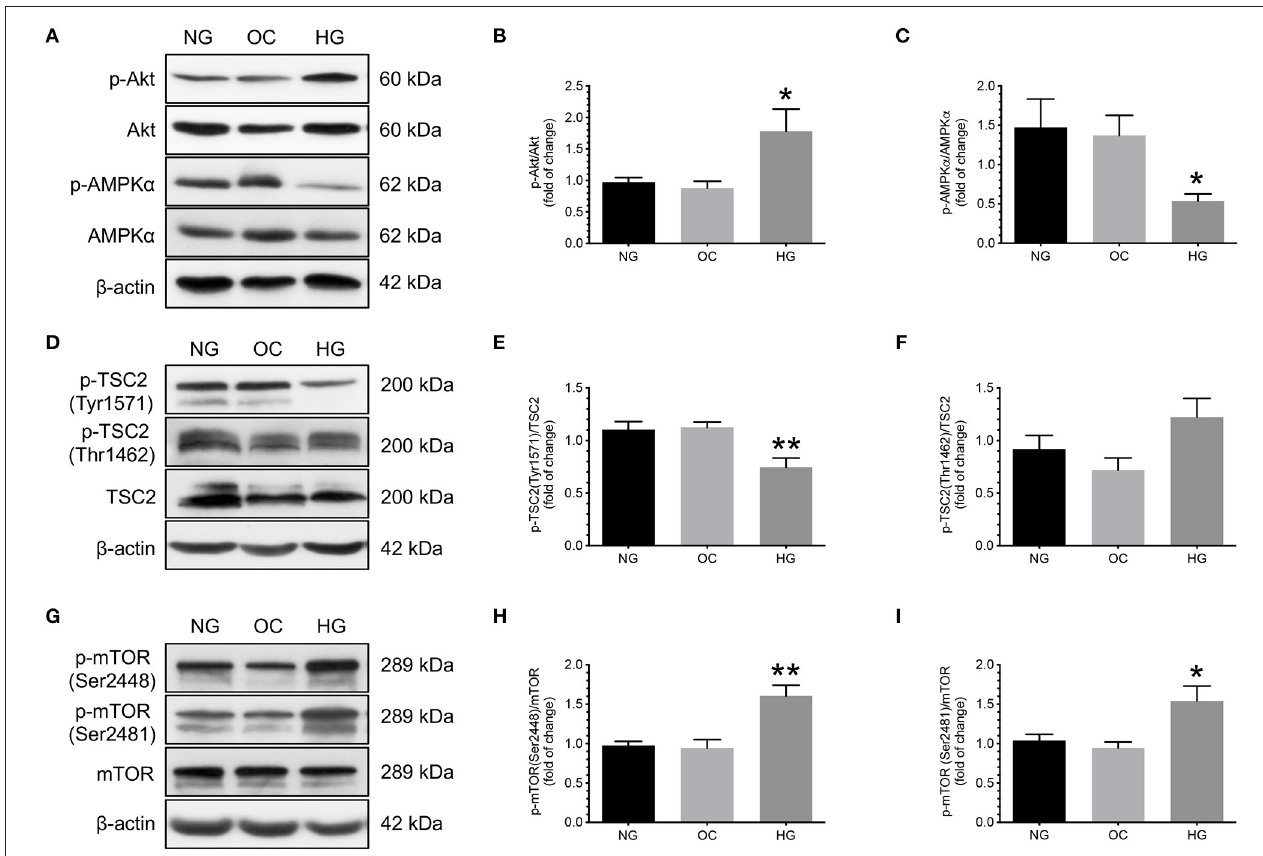
FIGURE 4 | Effects of increasing glucose concentration on the changes of Akt, AMPK α , TSC2, and mTOR phosphorylation in human cytotrophoblast cells. Primary cytotrophoblast cells were cultured under normoglycemic, hyperosmotic, and hyperglycemic conditions for 24h, and the levels of phosphorylated and total forms of Akt, AMPK α , TSC2, and mTOR were compared. Increasing D-glucose concentration led to higher p-Akt/Akt and lower p-AMPK/AMPK α than that of those under normoglycemic and hyperosmotic conditions (A–C) . These changes were concomitant with a decrease in p-TSC2 (Tyr1571) levels and an increase in mTOR phosphorylation (Ser2448 and Ser2481) (D,E,G–I) . No significant differences in the phosphorylated levels of TSC2 (Thr1462) were noted among the three experimental groups (D,F) . (A,D,G) Representative blots show the levels of phosphorylated and total forms of Akt, AMPK α , TSC2, and mTOR. β -actin was used to normalize loading variability. (B,C,E,F,H,I) Data are presented as mean ± SEM; n = 9 for each group. *, P < 0.05; **, P < 0.01; compared with cells cultured at normoglycemic conditions based on one-way analysis of variance followed by Tukey’s post-hoc test. NG, normoglycemic conditions; OC, hyperosmotic conditions; and HG, hyperglycemic